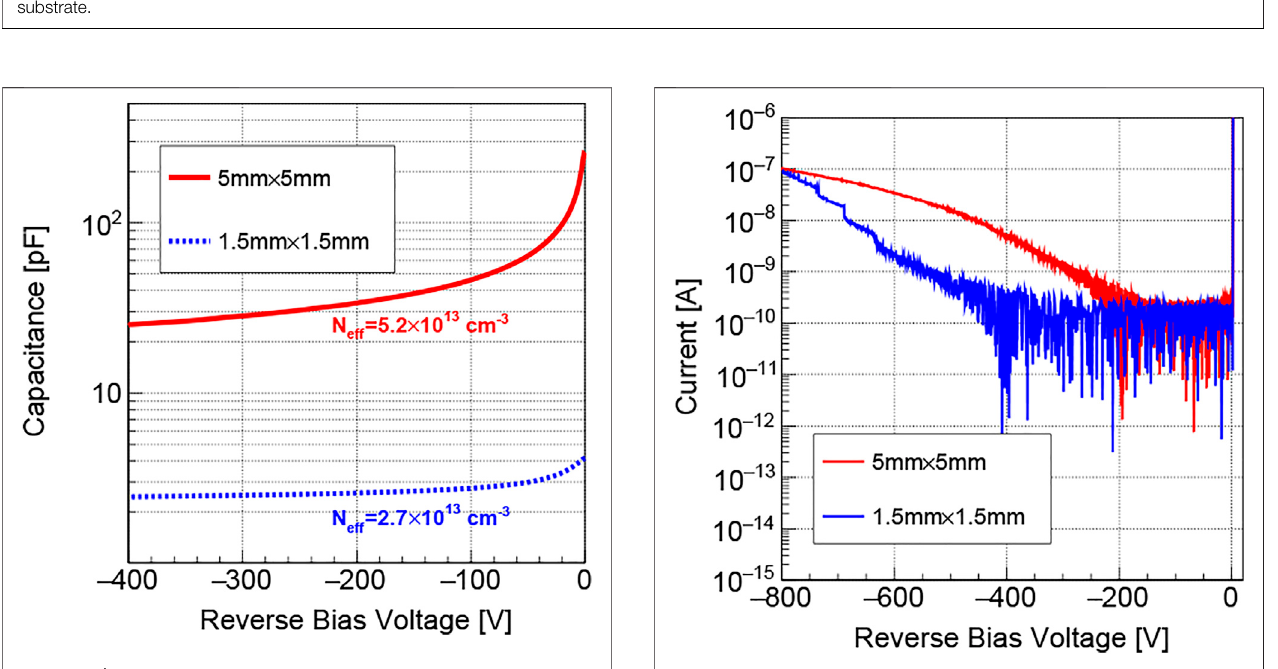
FIGURE 2 | Capacitance — voltage characteristics of two 4H-SiC PINs with different sizes. The capacitance is measured by a Keysight E4980A LCR Meter with a custom high bias voltage adapter (±400